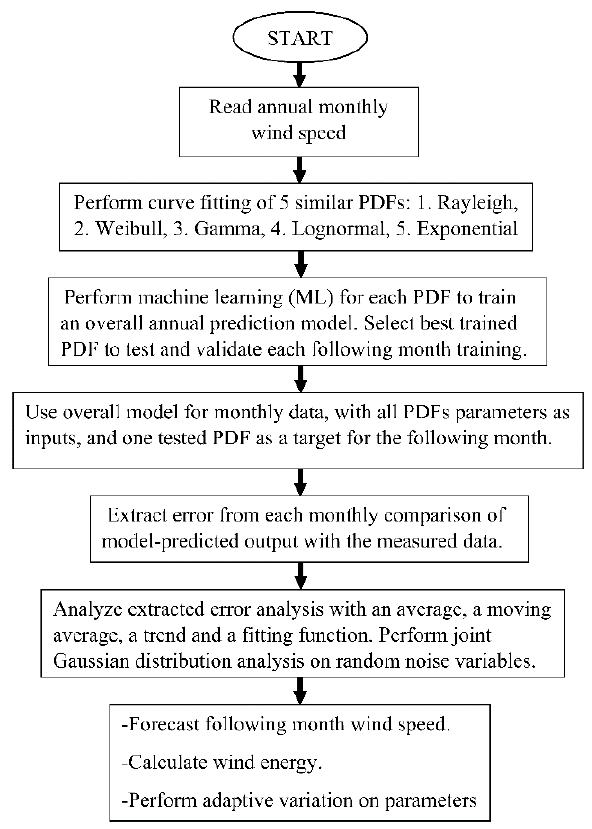
Figure 2. Implemented steps of the procedural algorithm.